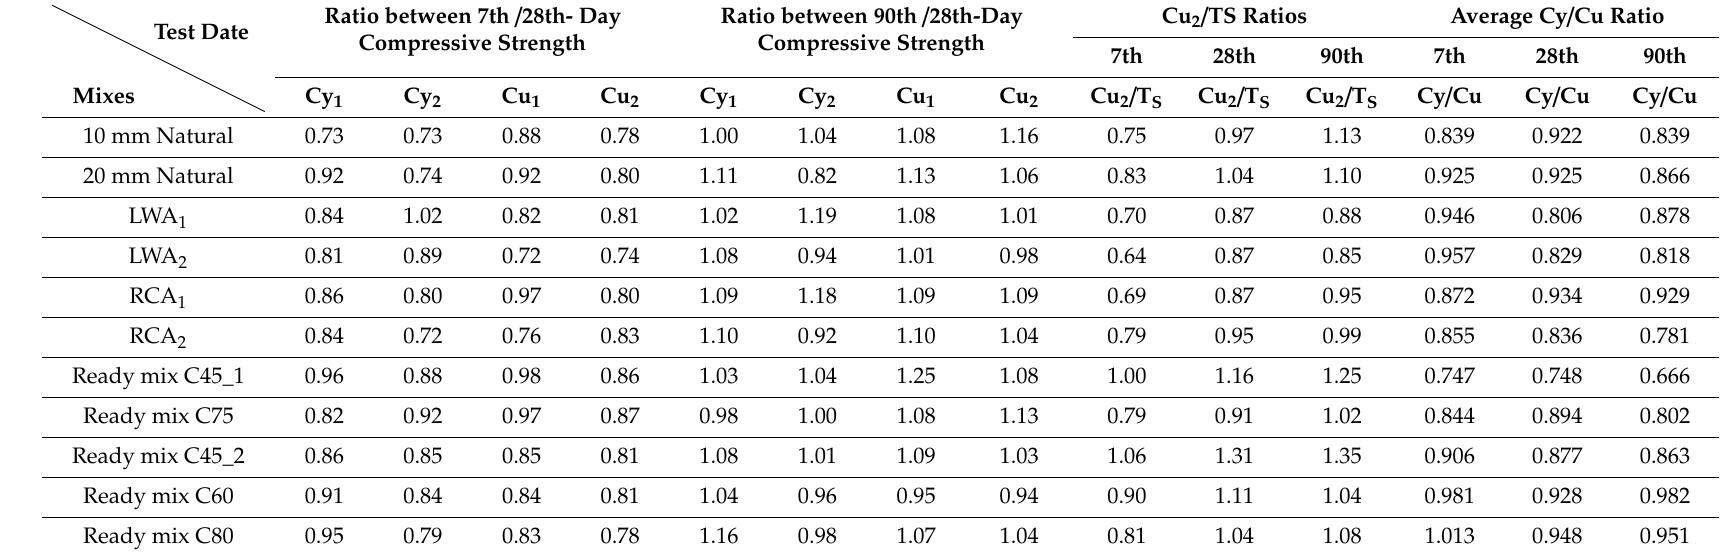
Table 8. Summary of compressive strength